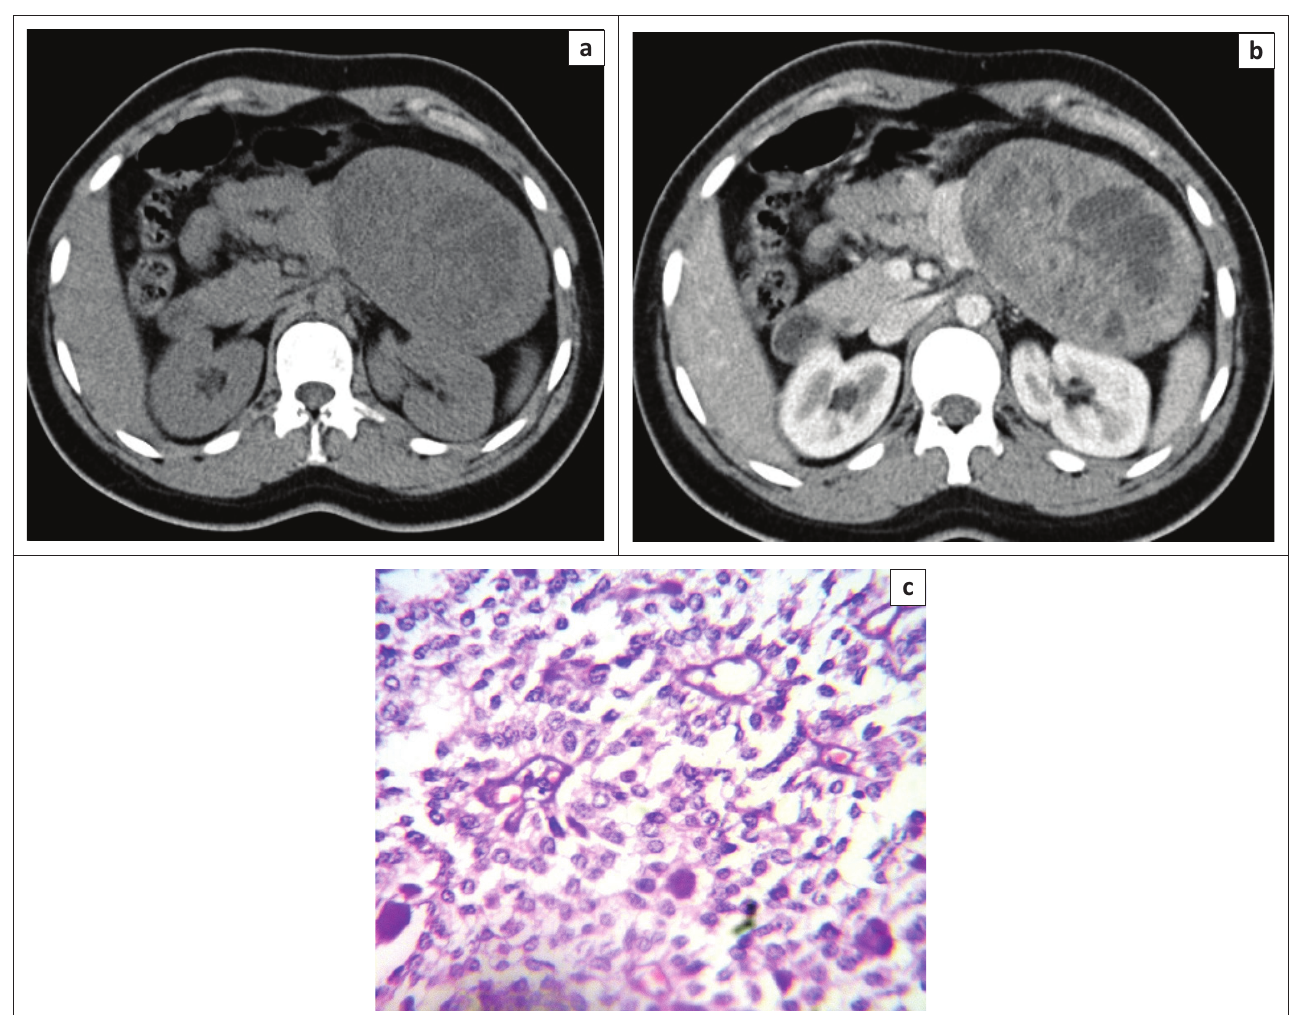
FIGURE 4: Axial non-contrast-enhanced computed tomography image (a) in a 31-year-old female patient showing a large lesion in relation to the tail of pancreas with a central hypodense area. Axial contrast-enhanced computed tomography image (b) in the same patient showing enhancement of the solid component of the lesion with non-enhancing areas suggestive of a solid pseudo-papillary tumour. High power magnification (40X) photomicrograph (c) of the same patient showing hyaline globules, pseudo-papillae and nuclear grooves confirming the diagnosis of solid pseudo-papillary tumour.